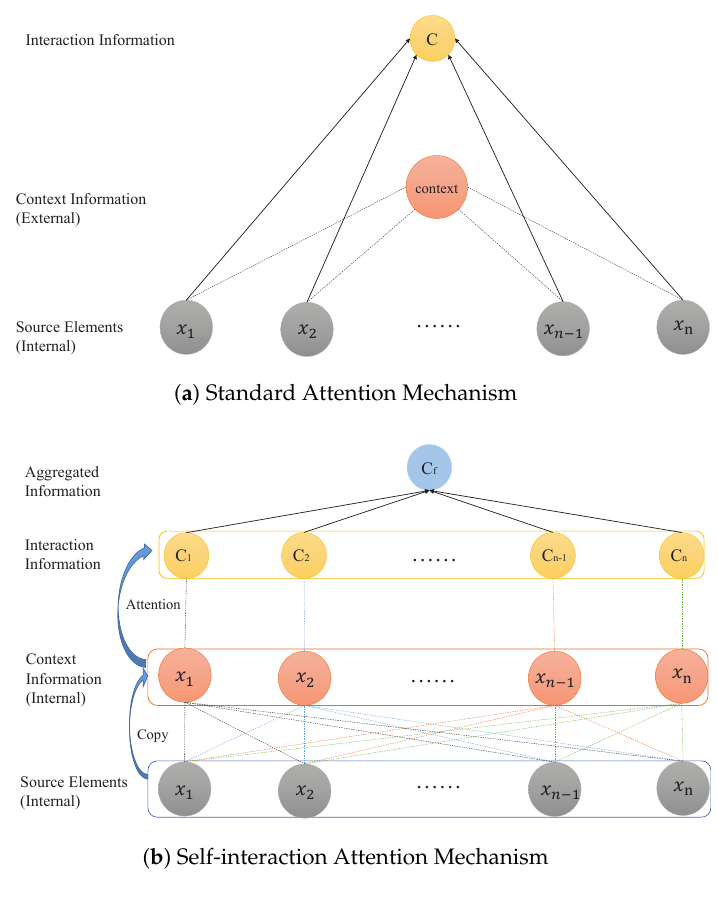
Figure 1. Comparison of Two Attention